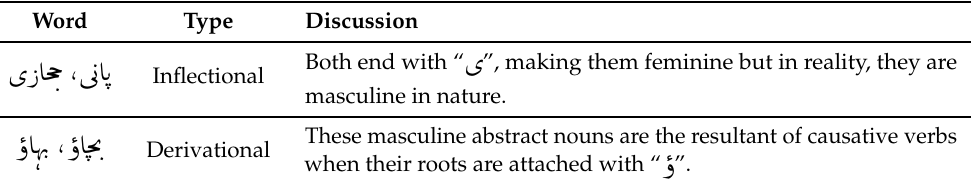
Table 3. Morphological-based discussion of a few inflectional and derivational words in the Urdu language.